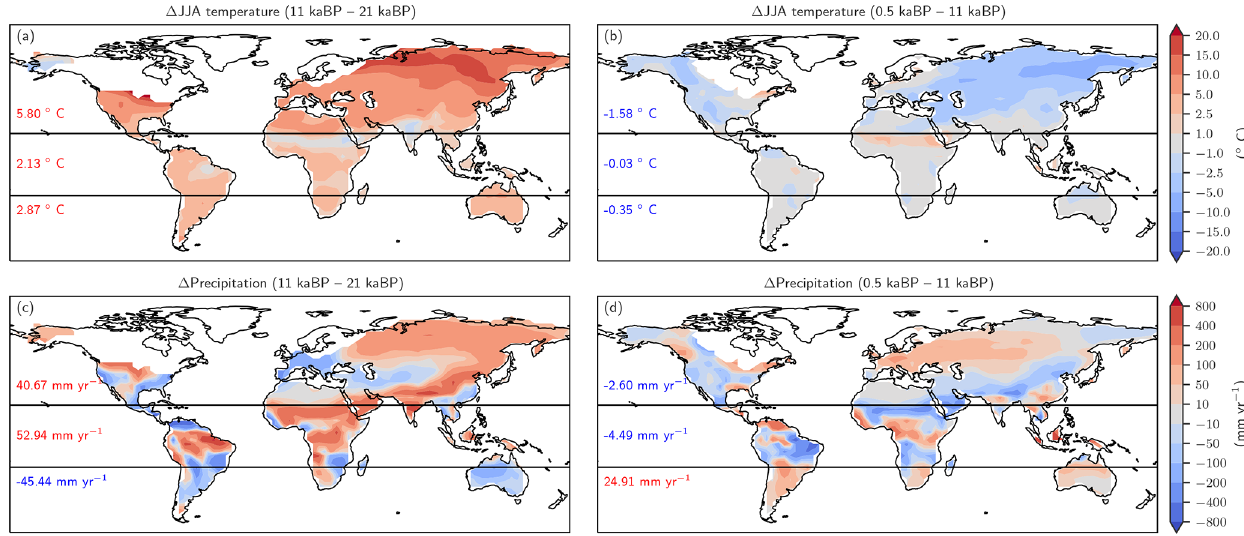
Figure 9. Changes in Northern Hemisphere summer temperature (June, July, August, panels a and b ) and annual precipitation (c, d) as simulated by CCSM3 and prescribed to LPX-Bern(v1.4N) for the glacial termination (a, c) and the Holocene (b, d) .